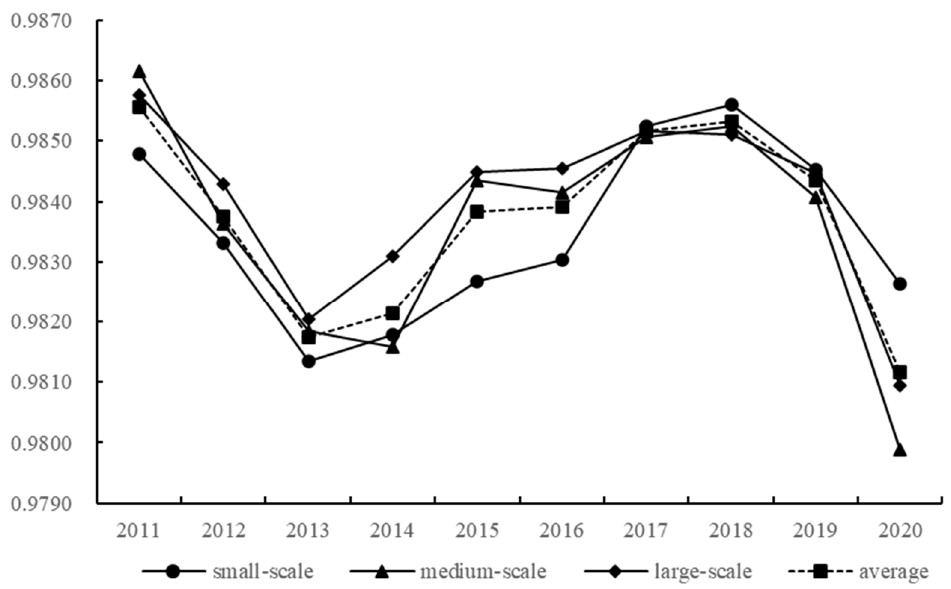
Figure 7. Annual technical efficiency of hog production of different scales in China from 2011 to 2020.